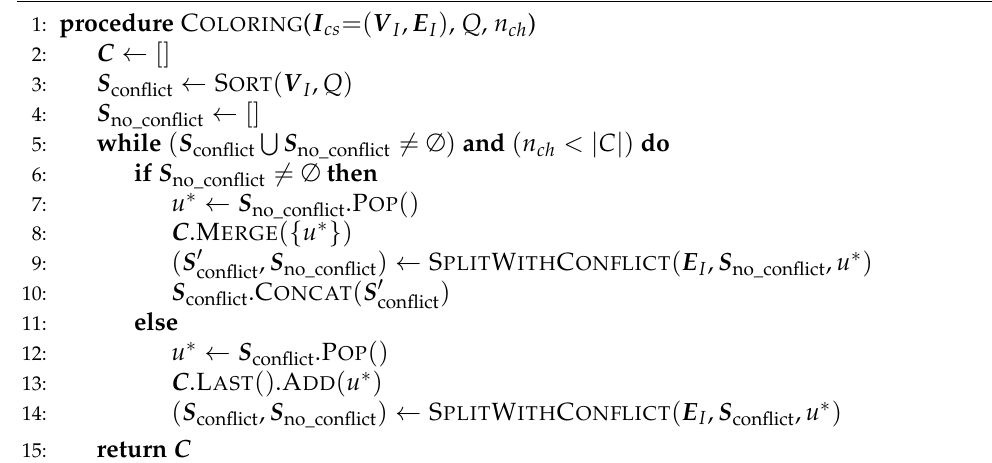
Algorithm 2 Coloring of conflict graph I cs with up to n ch colors, directed by traffic load